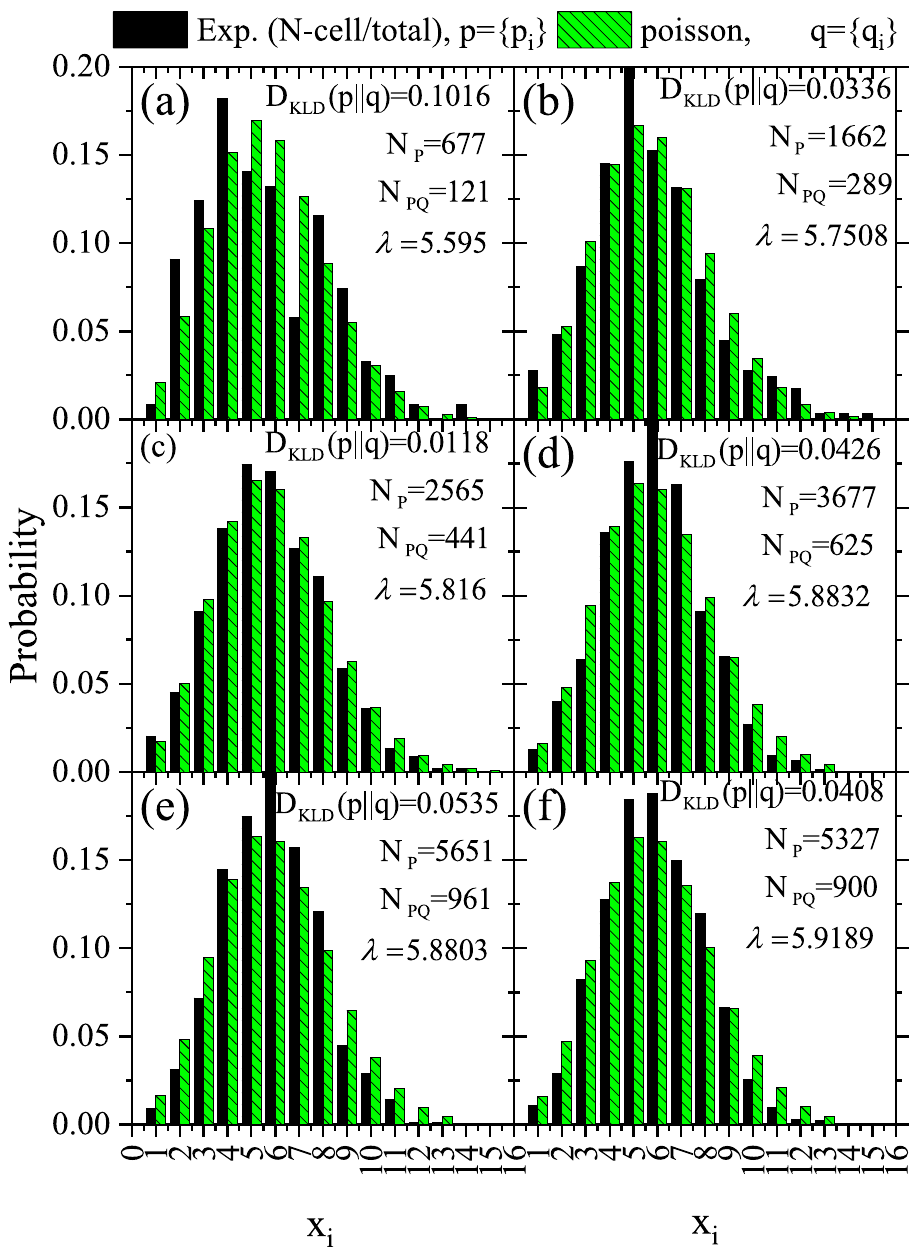
Figure 7. Probability histograms for the test hypothesis p for samples a2, b2, c3, d2, e2, and f2 versus the null hypothesis q versus the number of features x i within each quadrate. The null hypothesis is randomness based on Poisson distribution, in Eq. (2) assuming the same value of (cid:31) as given in Table